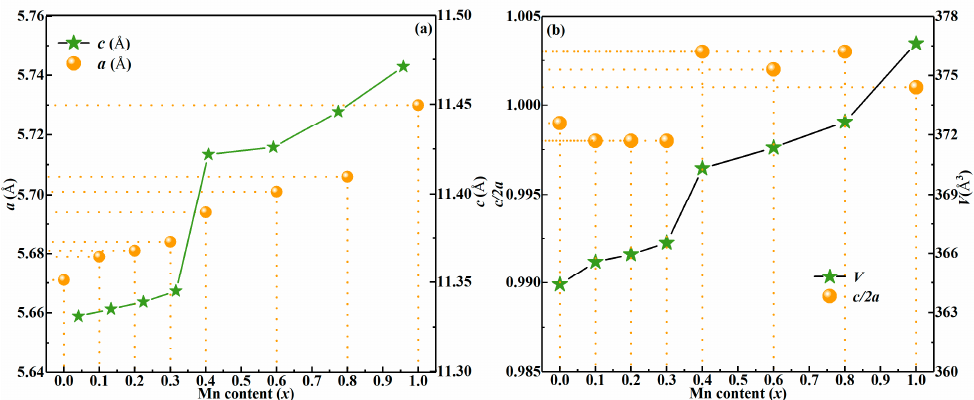
Figure 2. ( a ) The variation of a-axis lattice constant ( a ) and c-axis lattice constant ( c ) in CMZTSSe (0 ≤ x ≤ 1) alloy films. ( b ) The evolution of the unit cell volume ( V ) and the lattice parameters ( η = c /2 a ) with the Mn content for the Cu 2 Mn x Zn 1 − x Sn(S,Se) 4 (0 ≤ x ≤ 1) thin films.